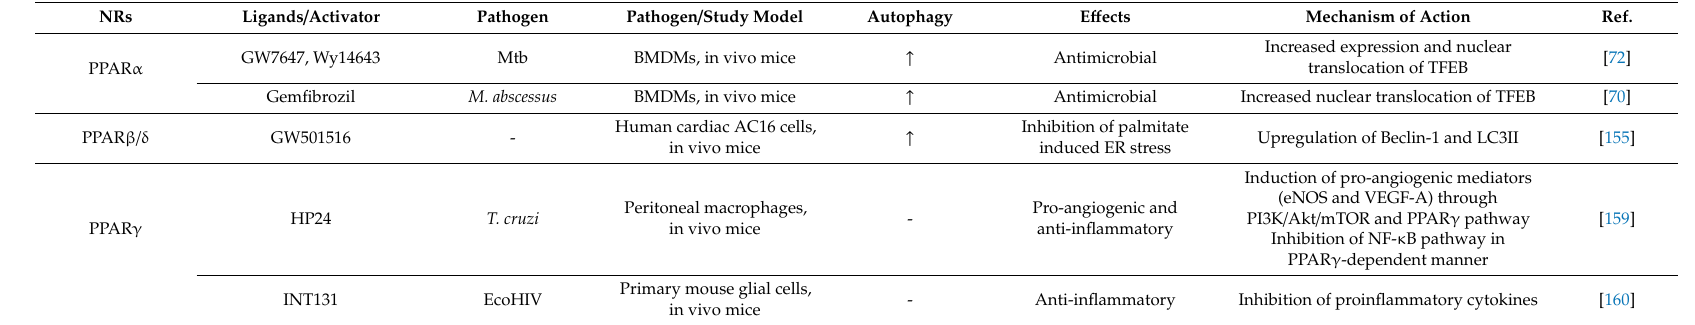
Table 3. Peroxisome proliferator-activated receptors